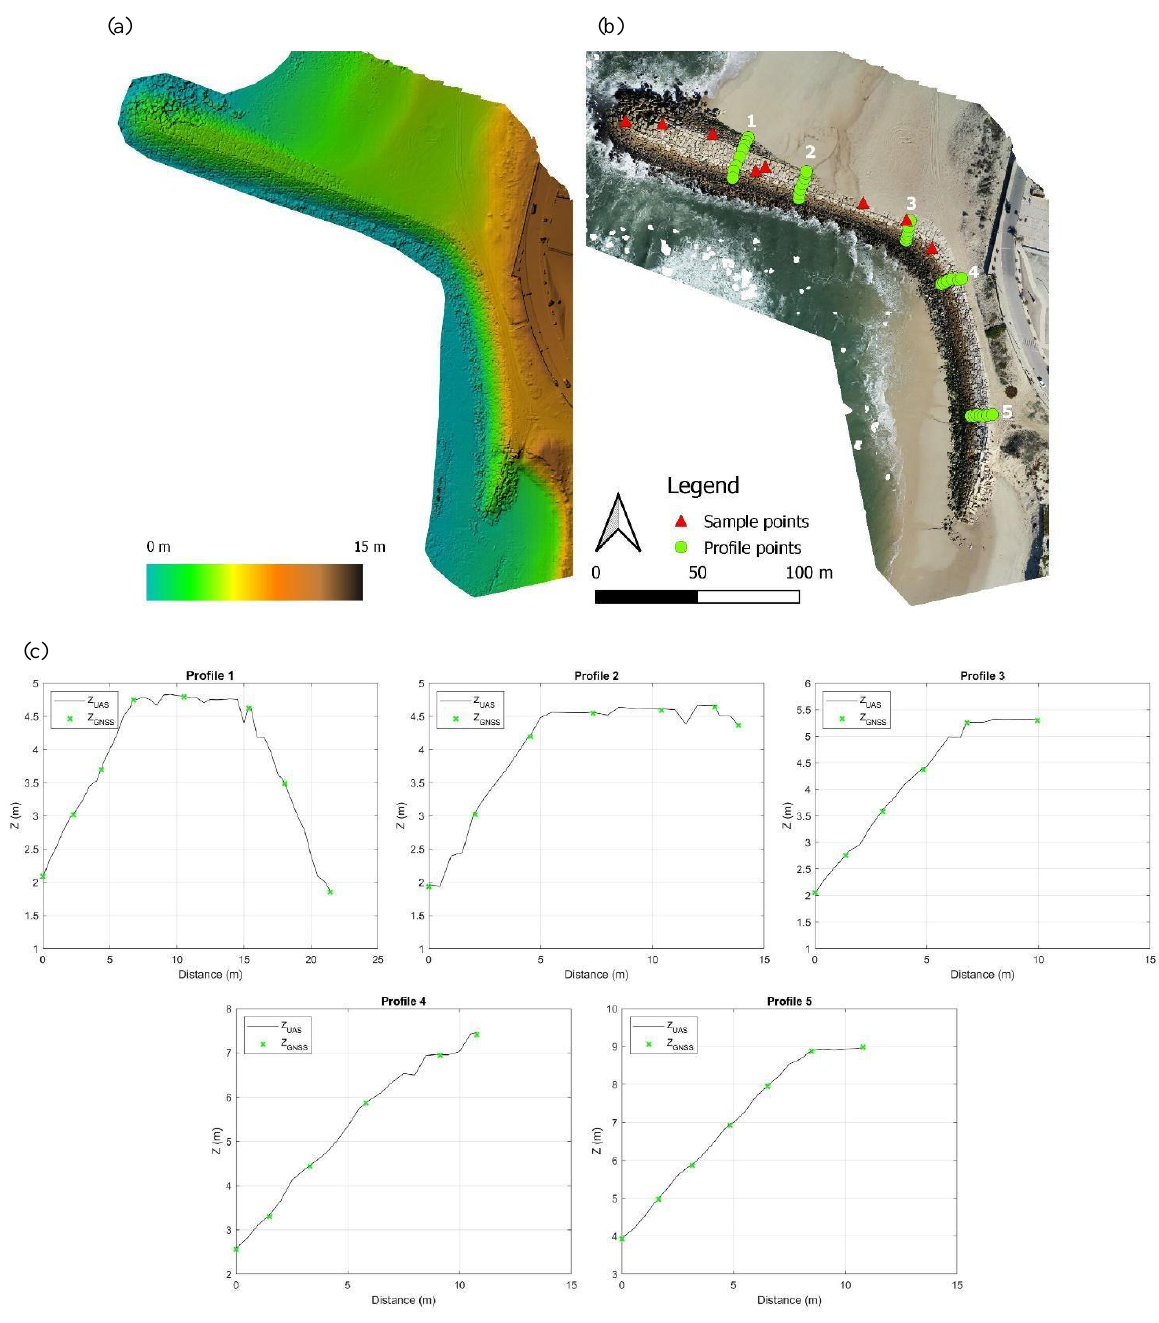
Figure 2 . Products obtained DJI Phantom 4RTK and generated in Agisoft Metashape. (a) Digital Surface Model (DSM); (b) Orthophoto and the point used in vertical accuracy analysis. (c) The profiles were obtained with GNSS (green crosses) and UAS DSM (black lines with 50 cm bin